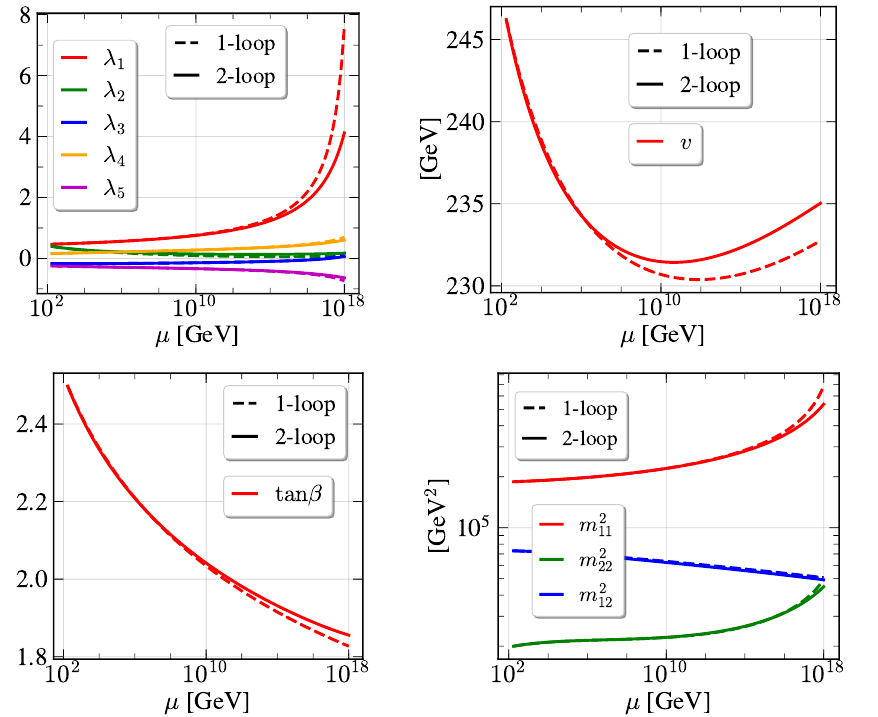
Figure 2 . Evolution of the type-I softly broken Z 2 parameter point in eq.